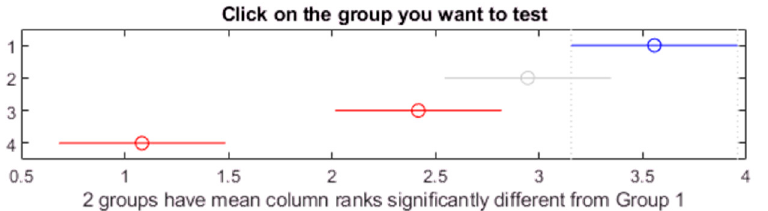
Figure 21. Post hoc Bonferroni test for oil Midel 1204 with different concentrations of surfactant Triton X.